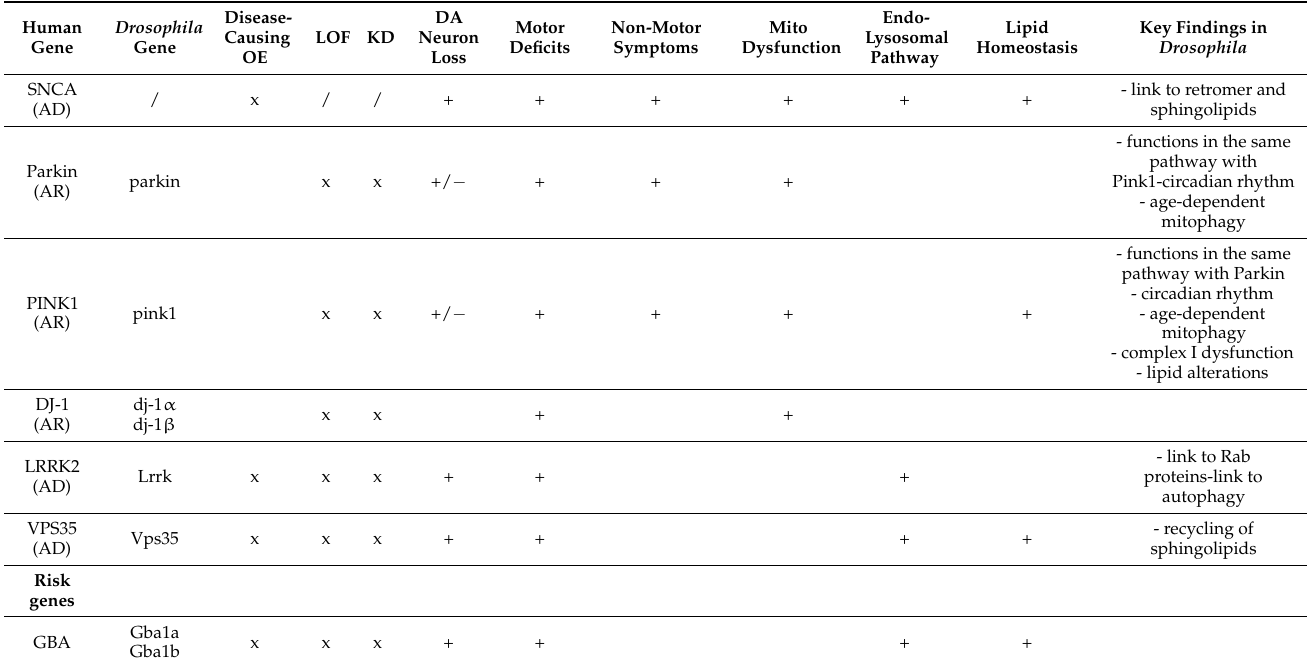
Table 2. PD models in flies and their